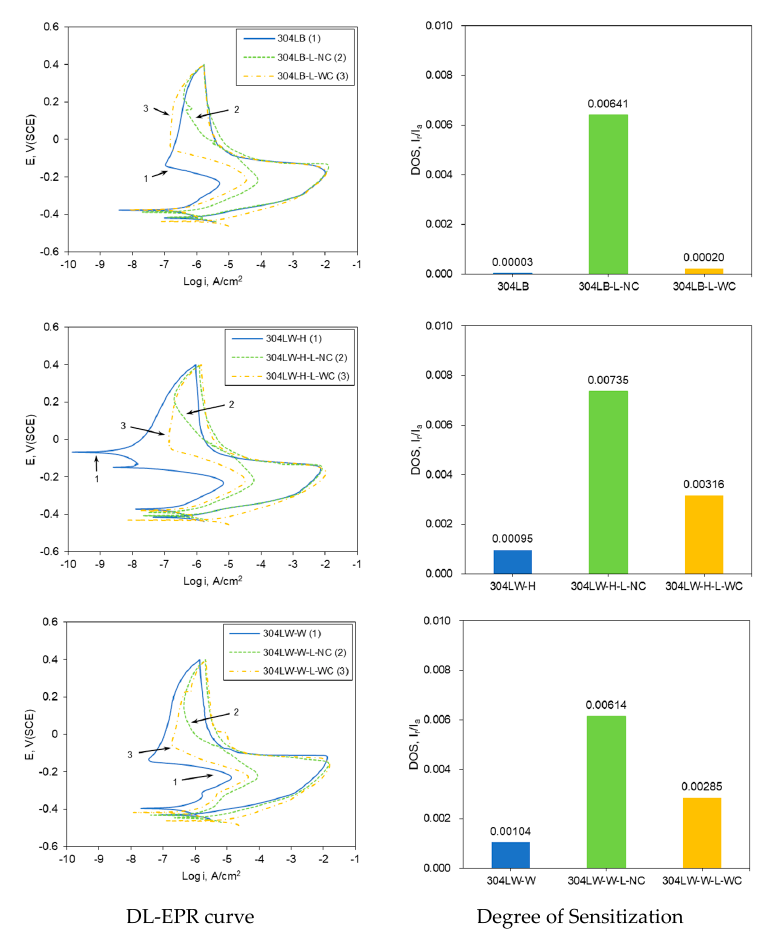
Figure 4. Effect of laser peening on the degree of sensitization on the outermost area of the cross- section of 304L by DL-EPR test.